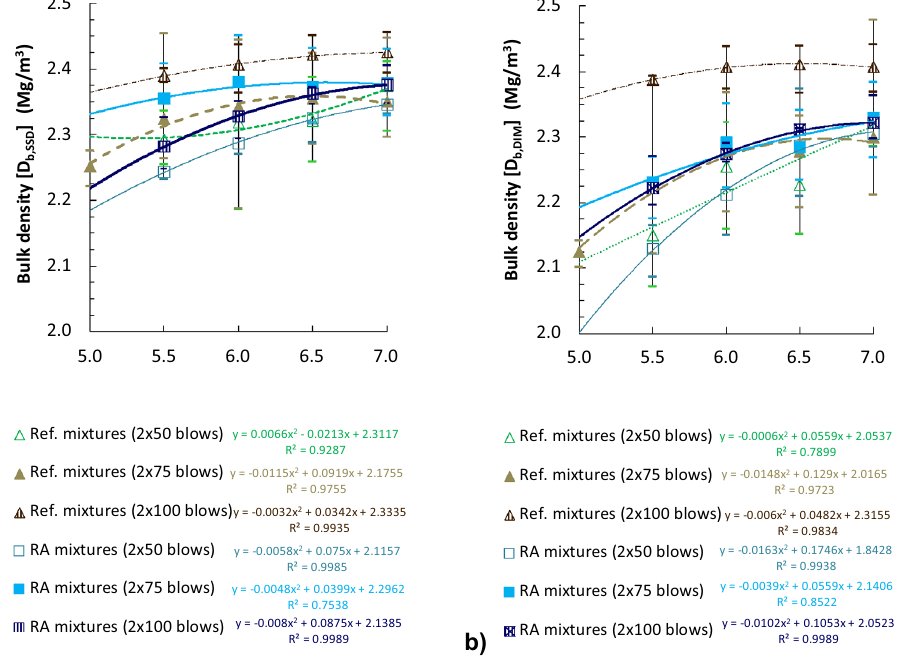
Figure 3. Densities of the bituminous mixtures on cylindrical specimens with different compaction energies: ( a ) bulk density (Proced. B: saturated surface dry, EN 12697-6); ( b ) Bulk density (Proced. D: geometric, EN 12697-6).